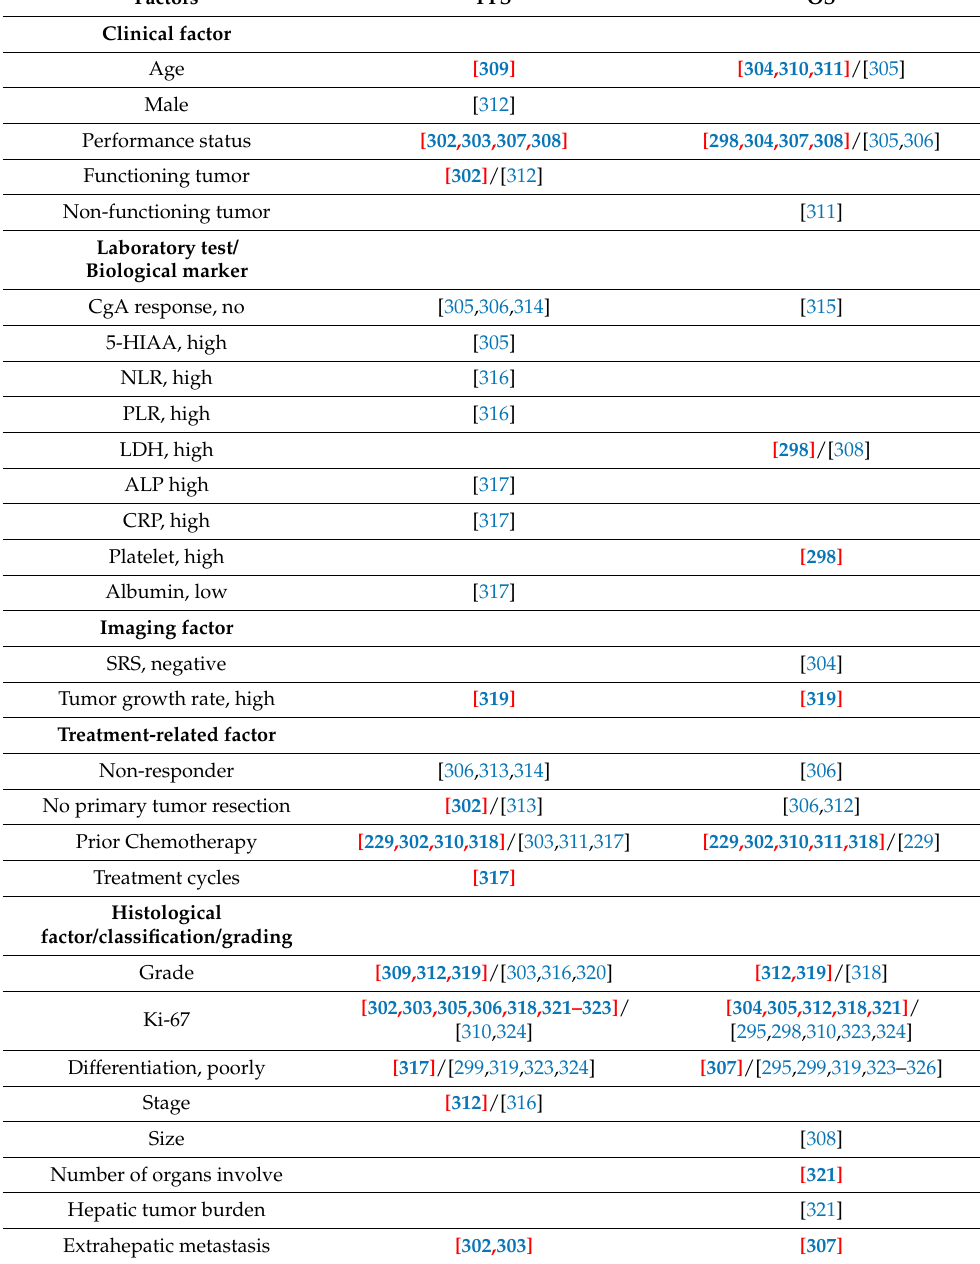
Table 4. Factors associated with worse PFS and OS with chemotherapy in advanced